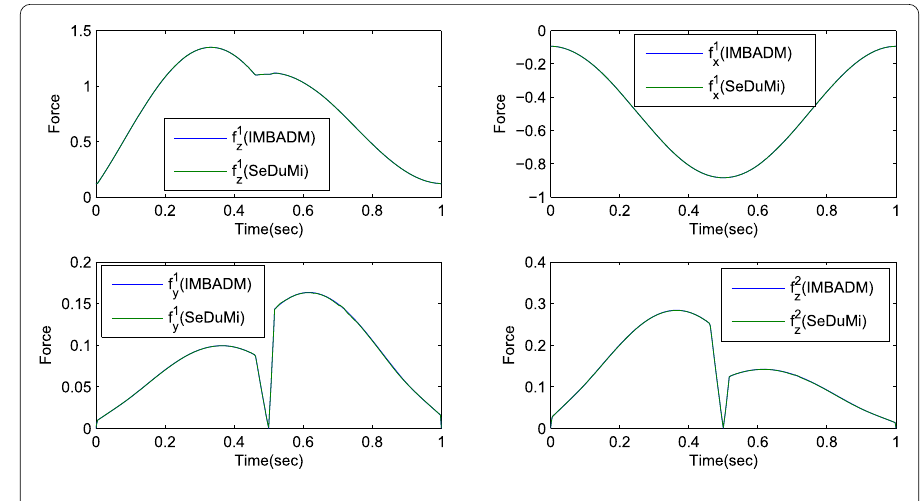
Figure 2 Comparative results of the two methods